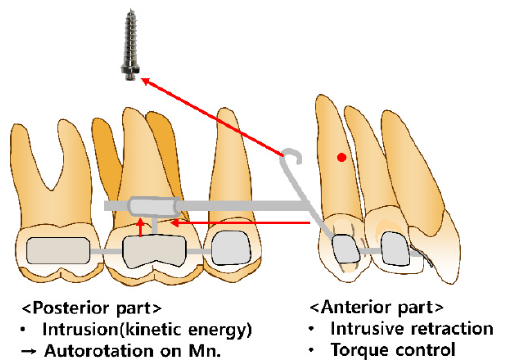
Figure 10. Biomechanics of the antero-posterior lingual retractor (APLR).